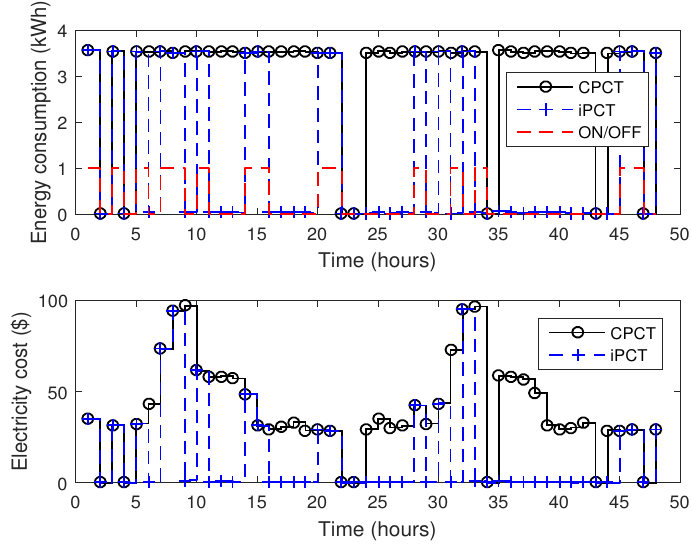
Figure 11. Total energy consumption and electricity cost of HVAC w.r.t total number of occupants ( t = 30 min time duration).